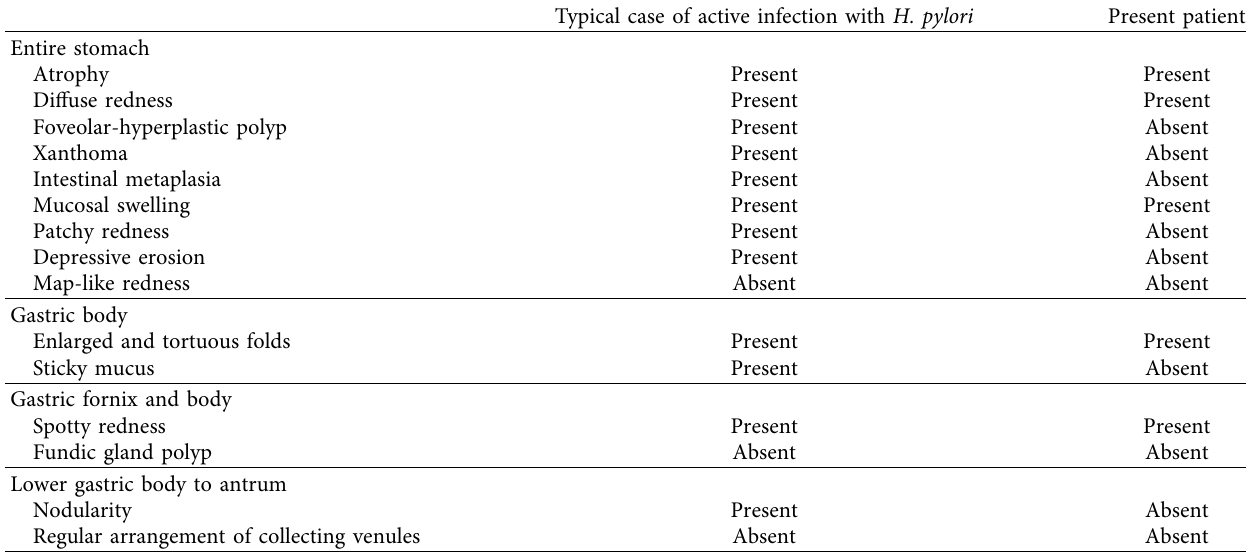
Table 1: Endoscopic features according to the Kyoto classification of gastritis. Typical case of active infection with H.